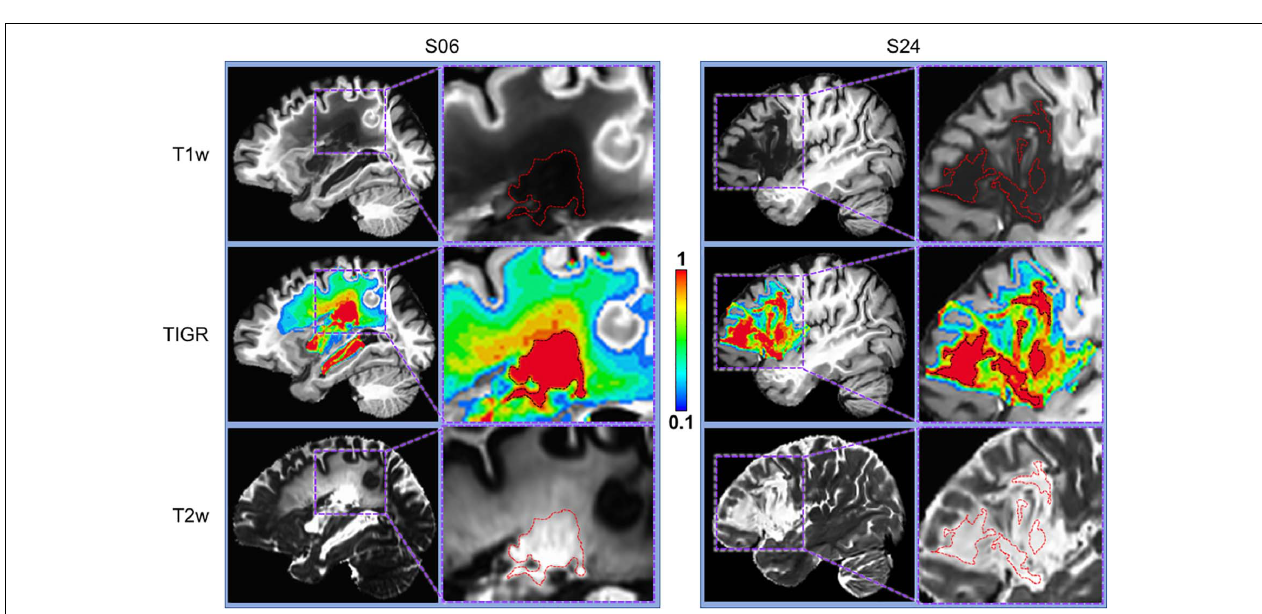
FIGURE 2 | Comparison of T1w, T2w, and TIGR maps from two chronic stroke participants. Each participant has a distinct lesion phenotype, including lesion location (S06, subcortical; S24, frontal) and characterization of lesion core and pericavitational perimeter. The dotted red or black lines in the zoomed images denote the cavitation, showing that identifying lesion core and quantifying the gradient in tissue damage from either T1w or T2w image alone may be difficult.